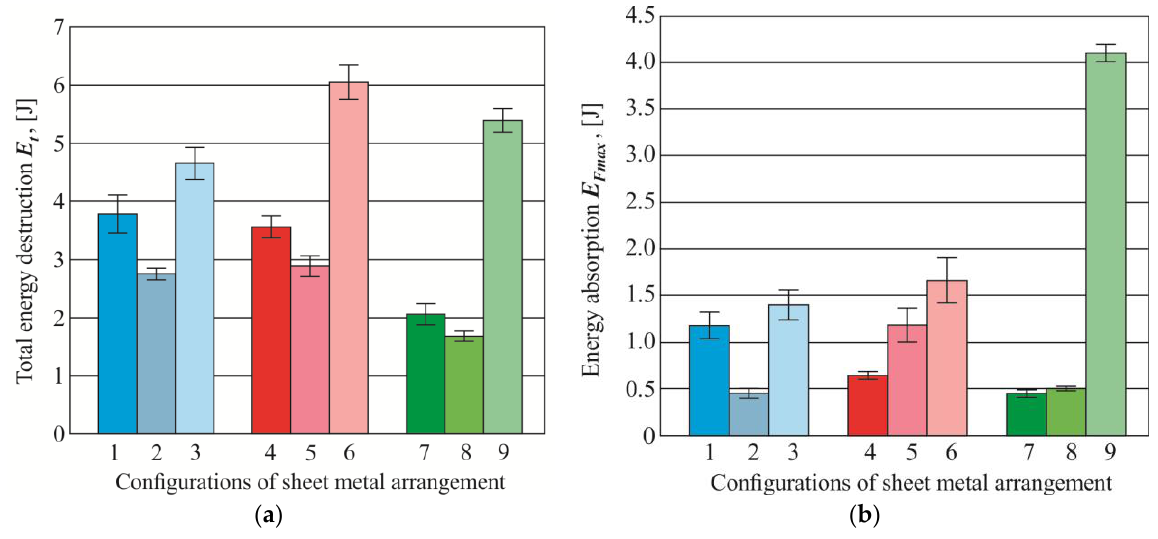
Figure 20. The dissipated energy: ( a ) up to fracture, ( b ) up to the maximum tensile shear force.